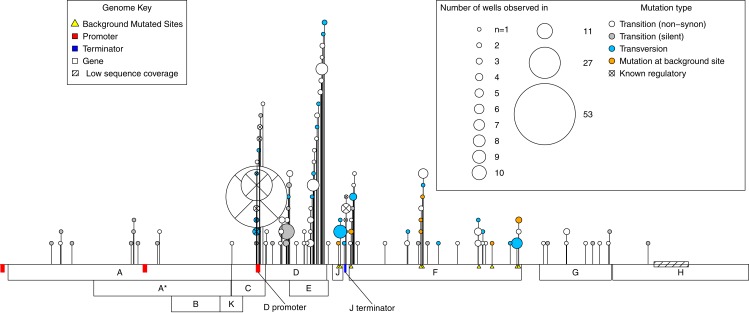
Genome location of all mutations observed across the experiment.A horizontal map of the genome is shown at the bottom of the plot; de novo mutations are indicated with pins above it. The size of the pin head indicates the number of independent wells with the mutation and the pin head color gives information about the mutation itself as described in the inset legend. Gene functions: A, DNA replication; A*, inhibits host DNA replication; B, internal scaffolding protein; C, DNA synthesis; D, external scaffolding protein; E, host cell lysis; F, major coat protein; G, major spike protein; H, pilot protein for DNA injection; J, DNA binding protein; K, unknown.